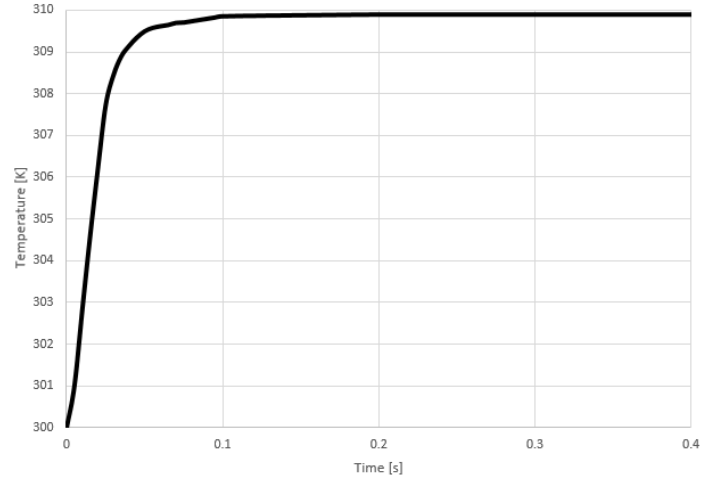
Figure 8. Temperature vs. Time during exhaling process.